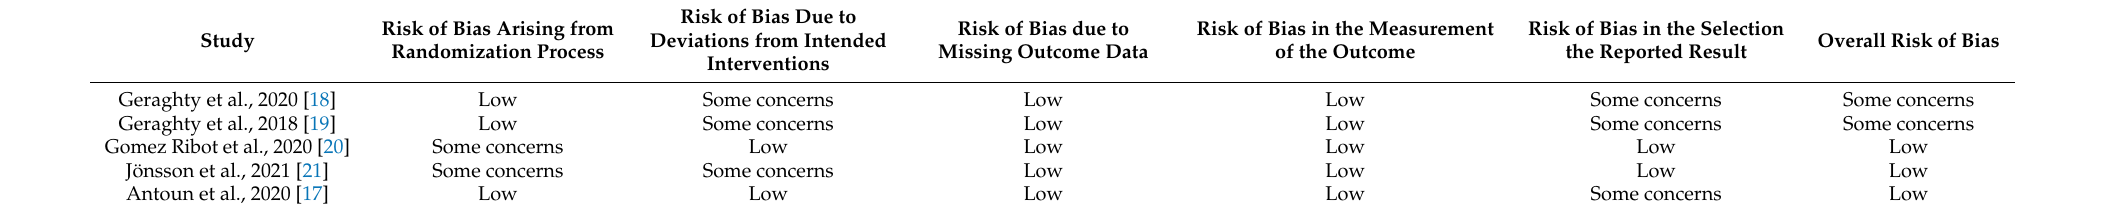
Table 4. Quality Assessment of Randomized Controlled